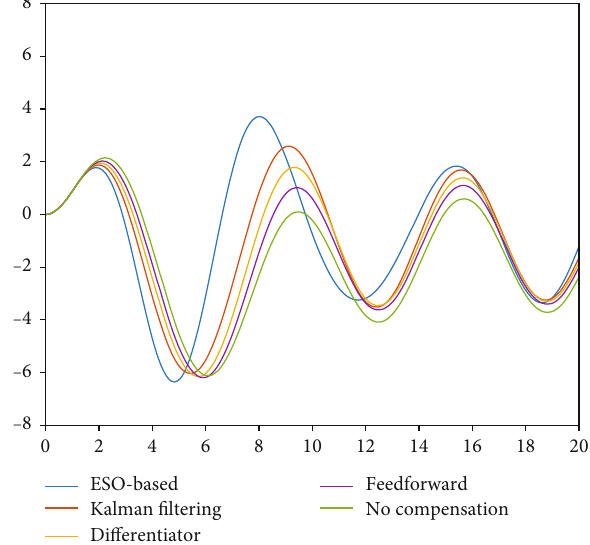
Figure 24: E ff ect of initial pointing